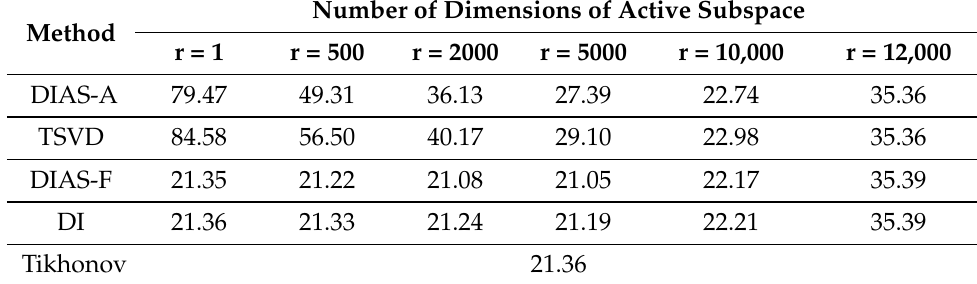
Table 4. Relative error (%) of inverse solutions by DIAS and Tikhonov regularization for optimal regularization case with α optimal = 1.3 × 10 5 , noise level